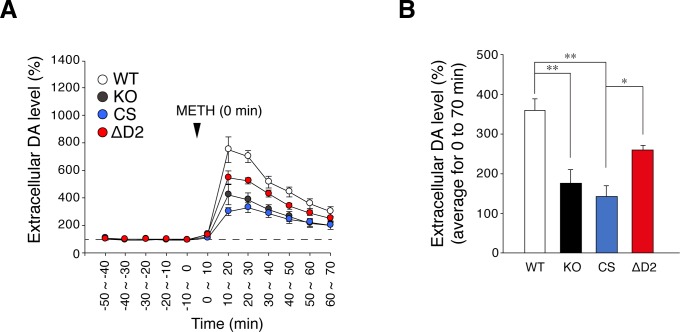
METH-evoked dopamine release in the nucleus accumbens.(A, B) In vivo microdialysis measurements of extracellular dopamine in the nucleus accumbens in freely moving mice. Perfusates were automatically collected at 10-min intervals and DA levels were measured. The plot shows the mean ± SE of DA levels in perfusates (n = 7 per group) (A). Dopamine levels were expressed as the percentage of averaged basal values (three points, -30 ~ -20 min, -20 ~ -10 min, and -10 ~ 0 min). (B) Summary of METH-evoked dopamine release. The graph shows the mean with SE of extracellular DA levels from 0 ~ 10 min to 60 ~70 min after the METH treatment. There were significant effects of genotype (F(3, 24) = 13.319, P = 0.000) by UNIANOVA. *, P < 0.05; **, P < 0.01, significant difference between the indicated groups by Tukey’s post-hoc HSD test.